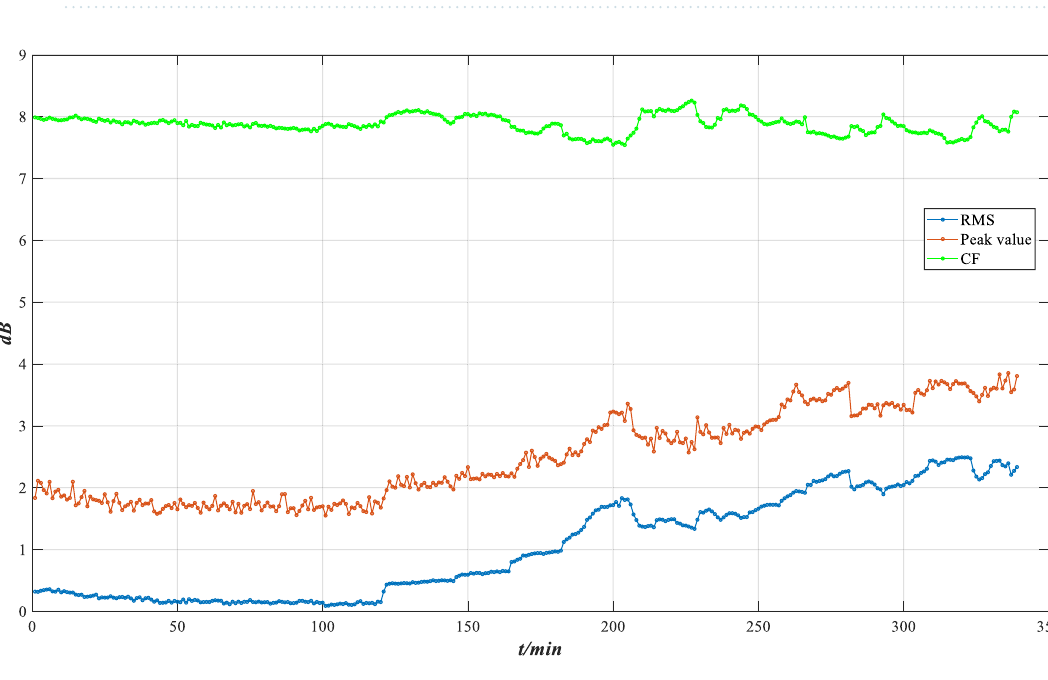
Figure 26. Characteristic indicators of XJTU-SY